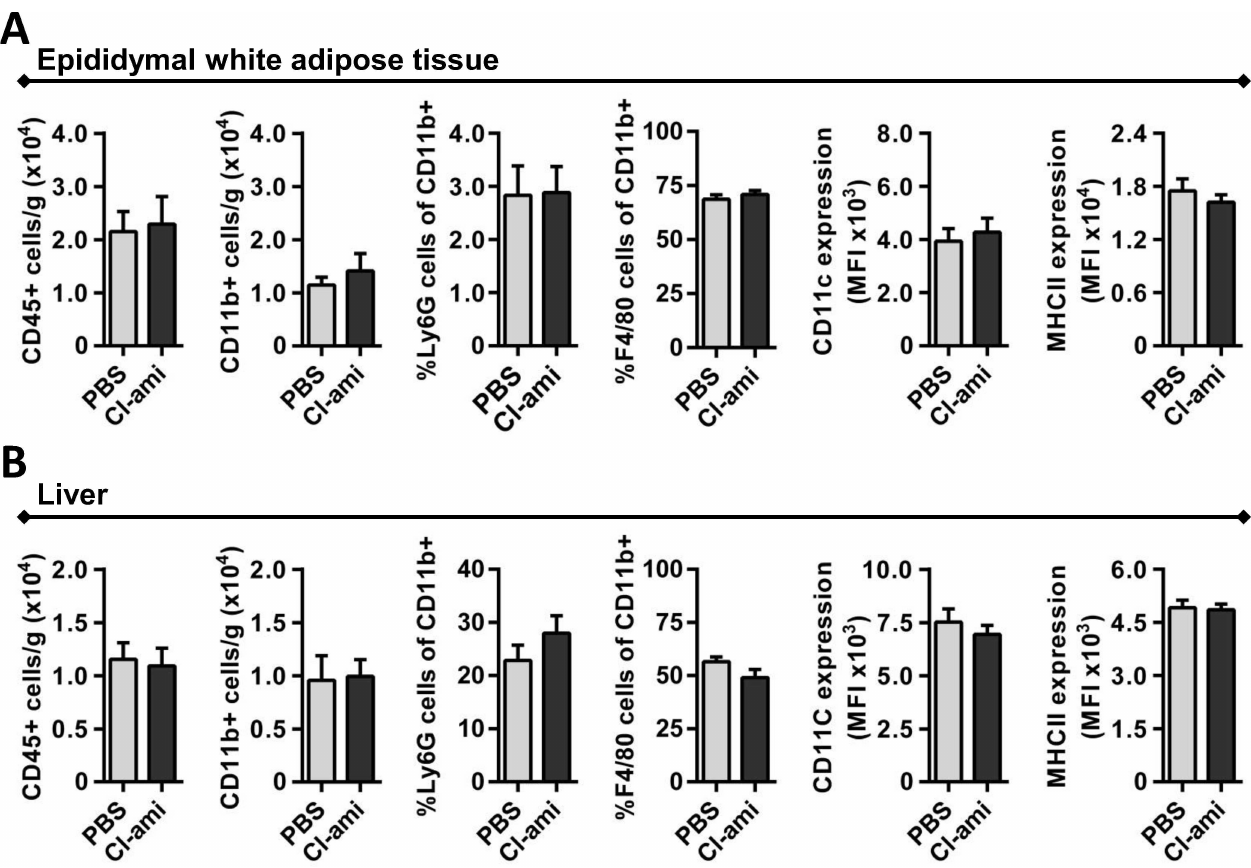
Fig 2. Effect of Cl-amidine treatment on immune cell accumulation and activation in adipose tissue and liver. A) White adipose tissue was digested by 0.25 mg/mL Liberase to isolate the resident immune cells. Flow cytometry analysis was performed for leukocytes(CD45 + ), myeloid cells (CD45 + /CD11b + ), neutrophils (CD45 + /CD11b + /Ly6G + ), macrophages (CD45 + /CD11b + /F4/80 + ) and expression of macrophagepro- inflammatory markers CD11c and MHCII on macrophages. B) Similar flow cytometry was performed on liver resident immune cells. Data is represented as mean ± SEM, n = 10 for each group unless stated